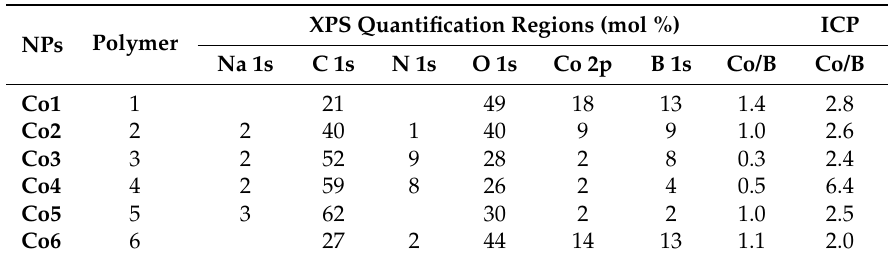
Table 1. Elemental quantification by X-ray photoelectron spectroscopy (XPS) and induced coupled plasma (ICP) of Co1 – 6 NPs. plasma (ICP) of Co1 – 6